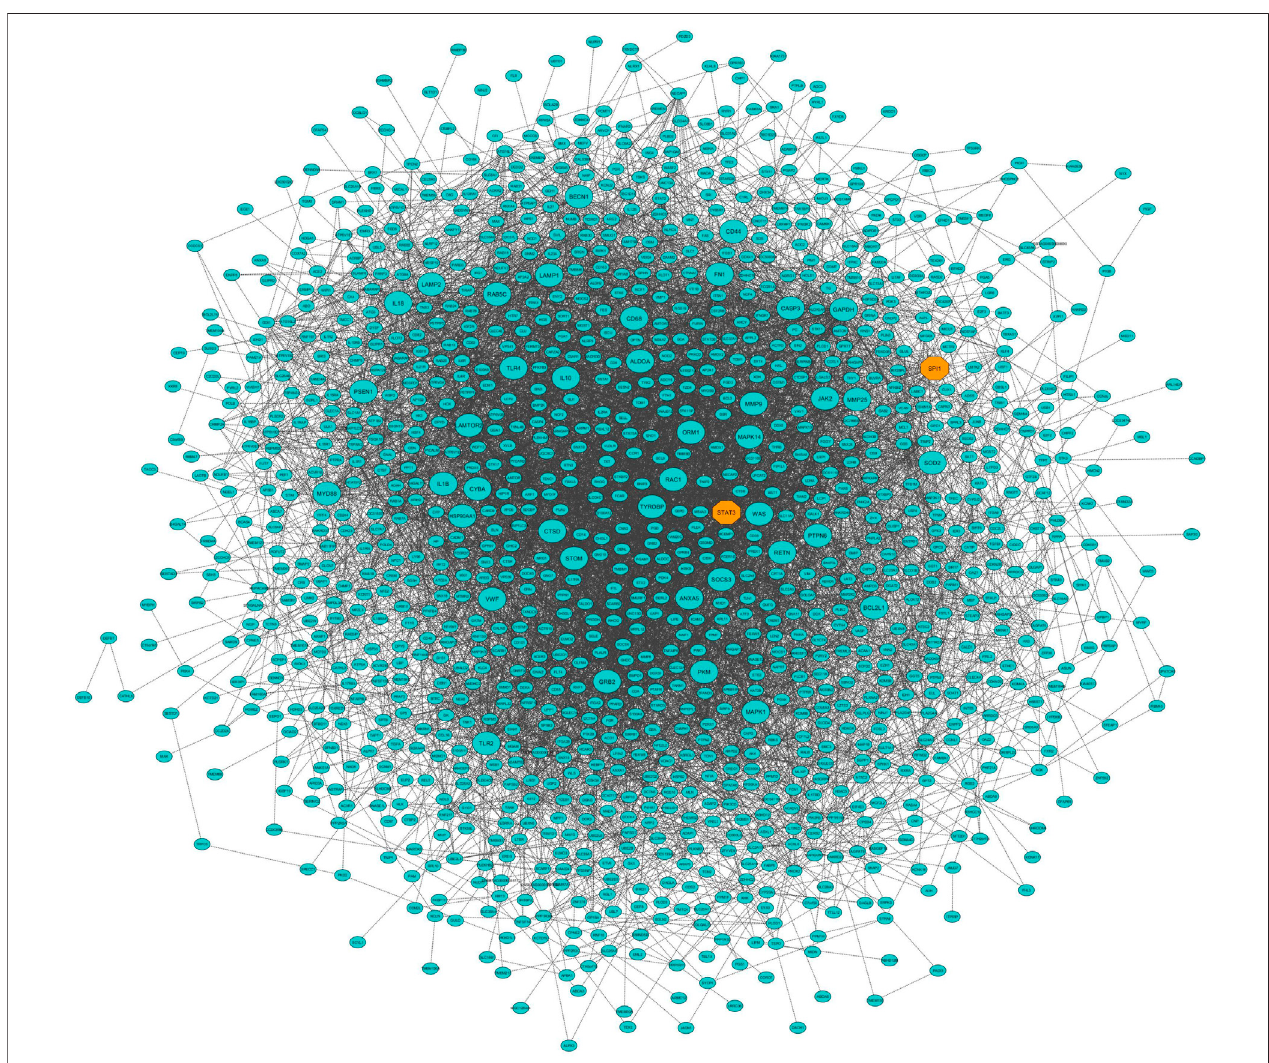
FIGURE 6 | Protein – protein interaction (PPI) network based on the hub genes of the turquoise module (identi fi ed by module – trait relationships method). Larger nodes and orange octagons represent hub – hub genes and transcription factors, respectively.